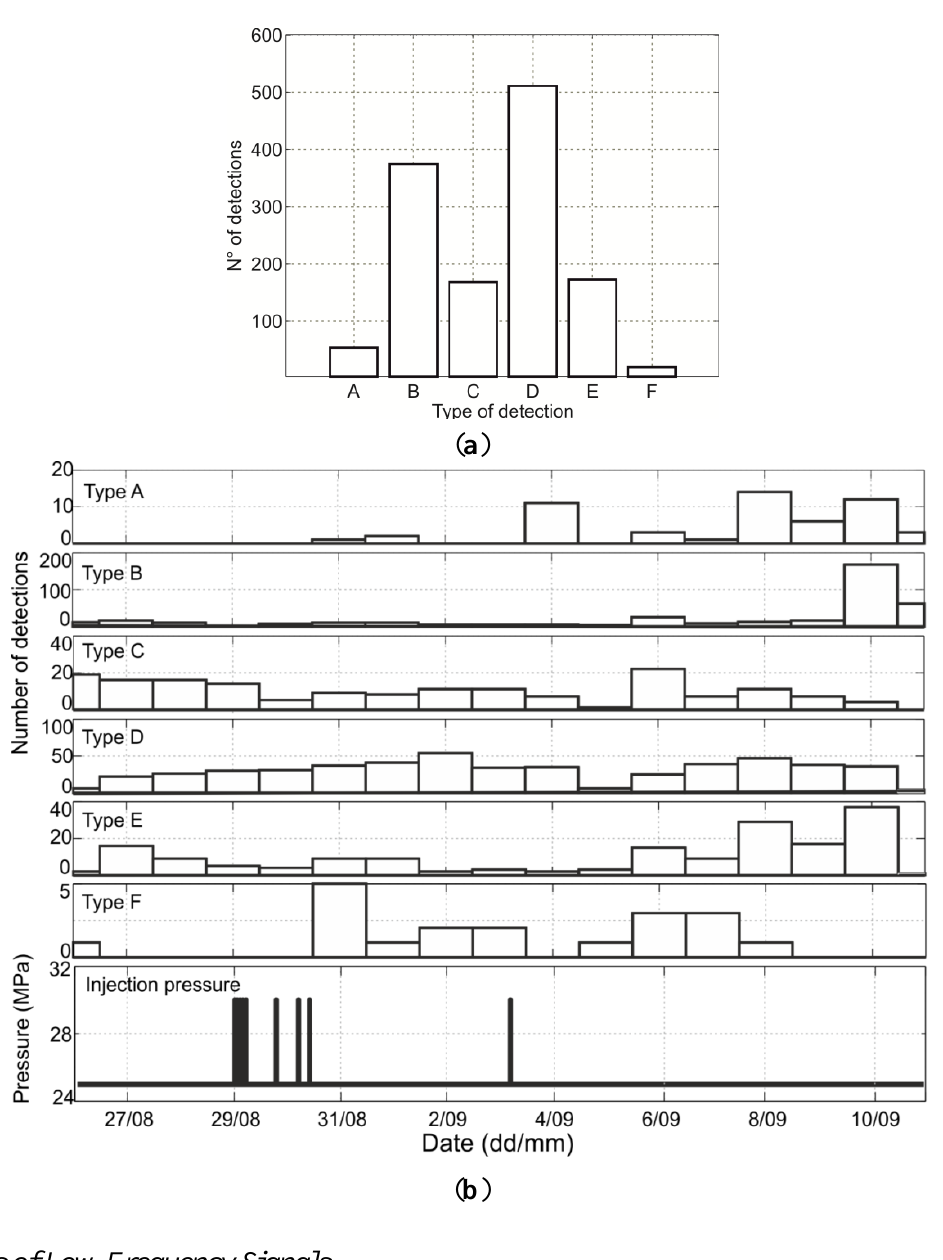
Figure 6. ( a ) Number of STA/LTA detections of each type detected during the entire analyzed period; ( b ) From top to bottom: daily distribution of detection types from A to F and well-head pressure in the Injector well I1 during the two-week